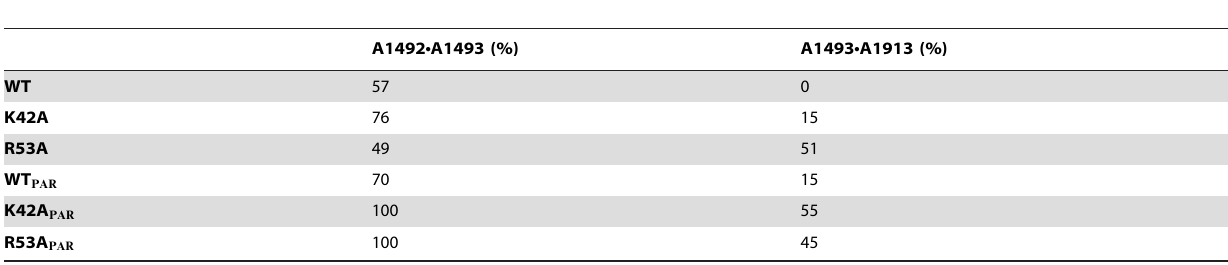
Table 2. Stacking frequency for A1492(h44) N A1493(h44) and A1493(h44) N A1913(H69).